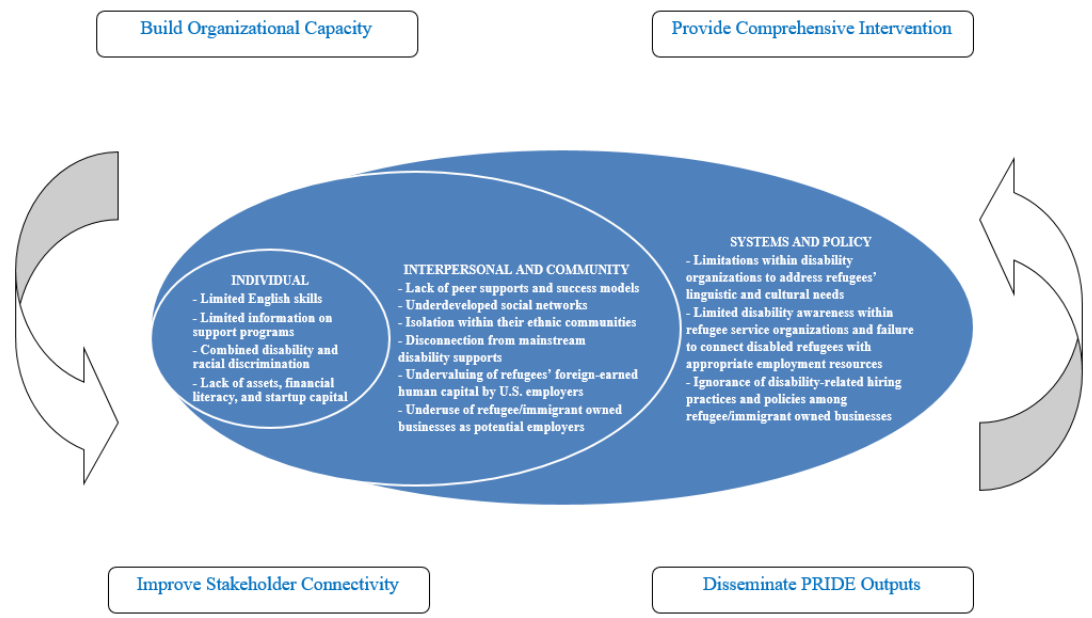
Figure 1. PRIDE’s conceptual framework based on the social ecological model of human development.